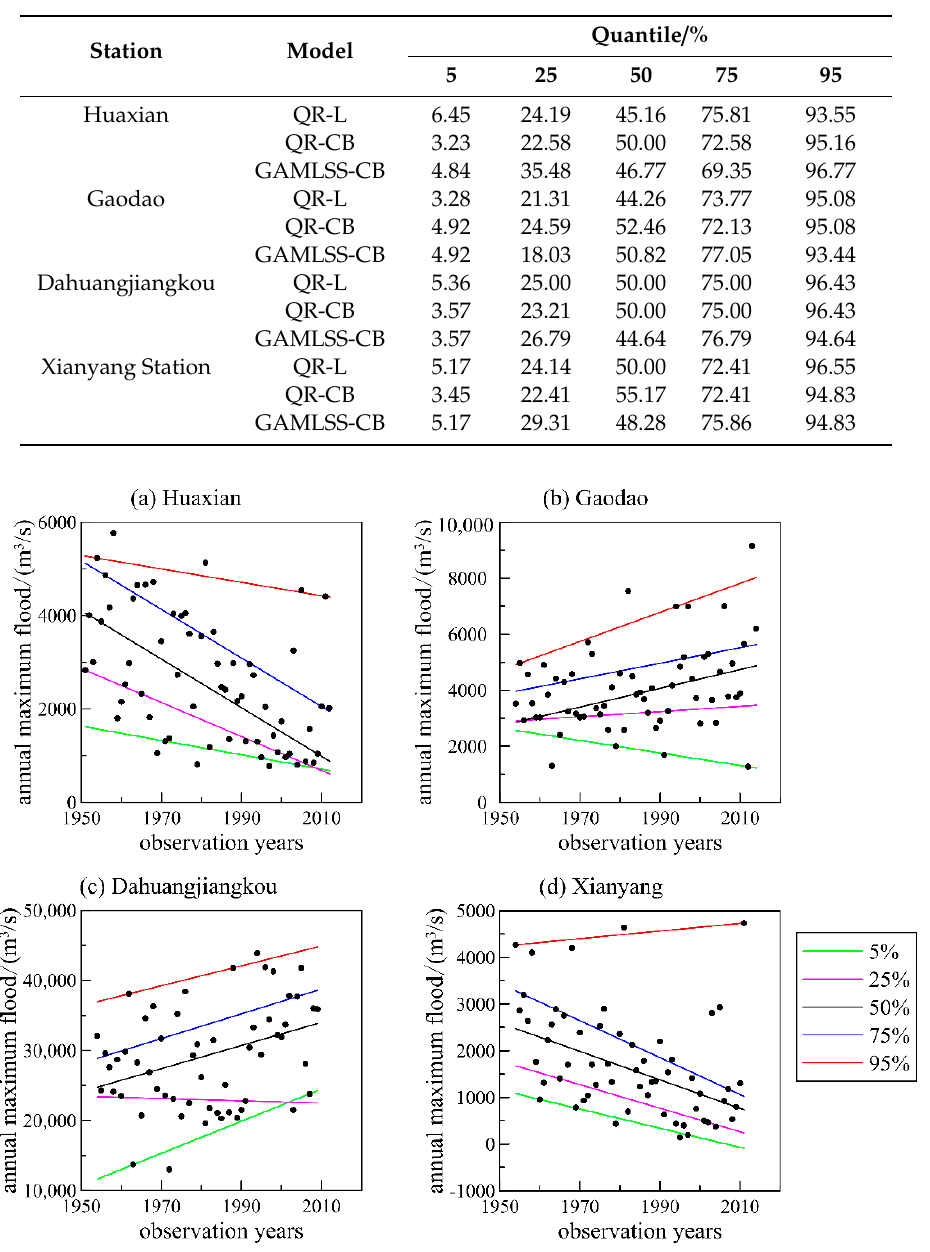
Figure 4. Quantile curves of QR-L model for ( a ) Huaxian station; ( b ) Gaodao station; ( c ) Dahuangjiangkou station; ( d ) Xianyang station.